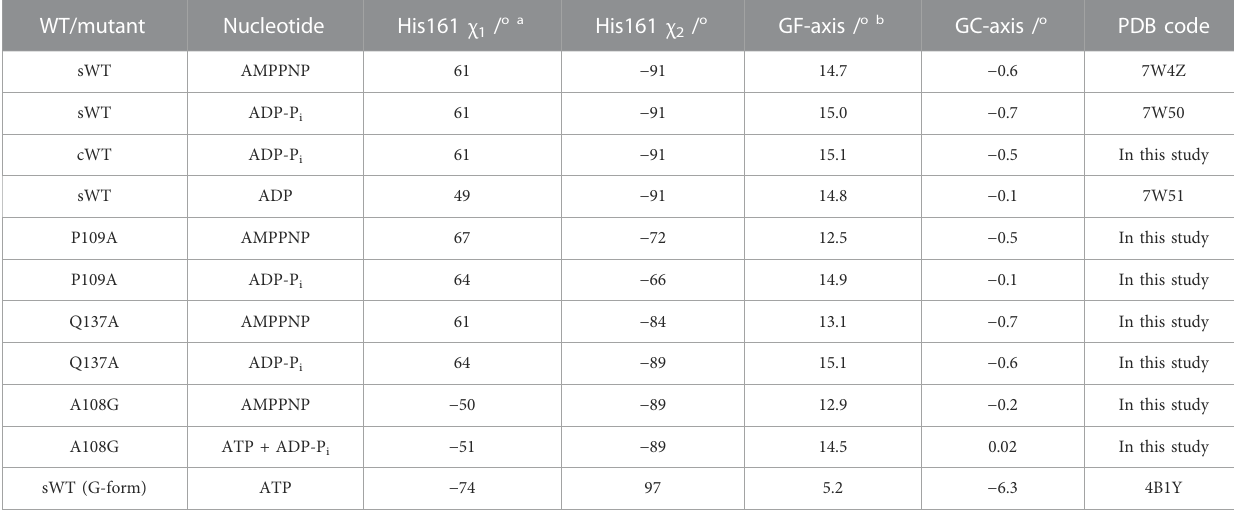
TABLE 2 Summary of actin conformation, nucleotide state, and His161